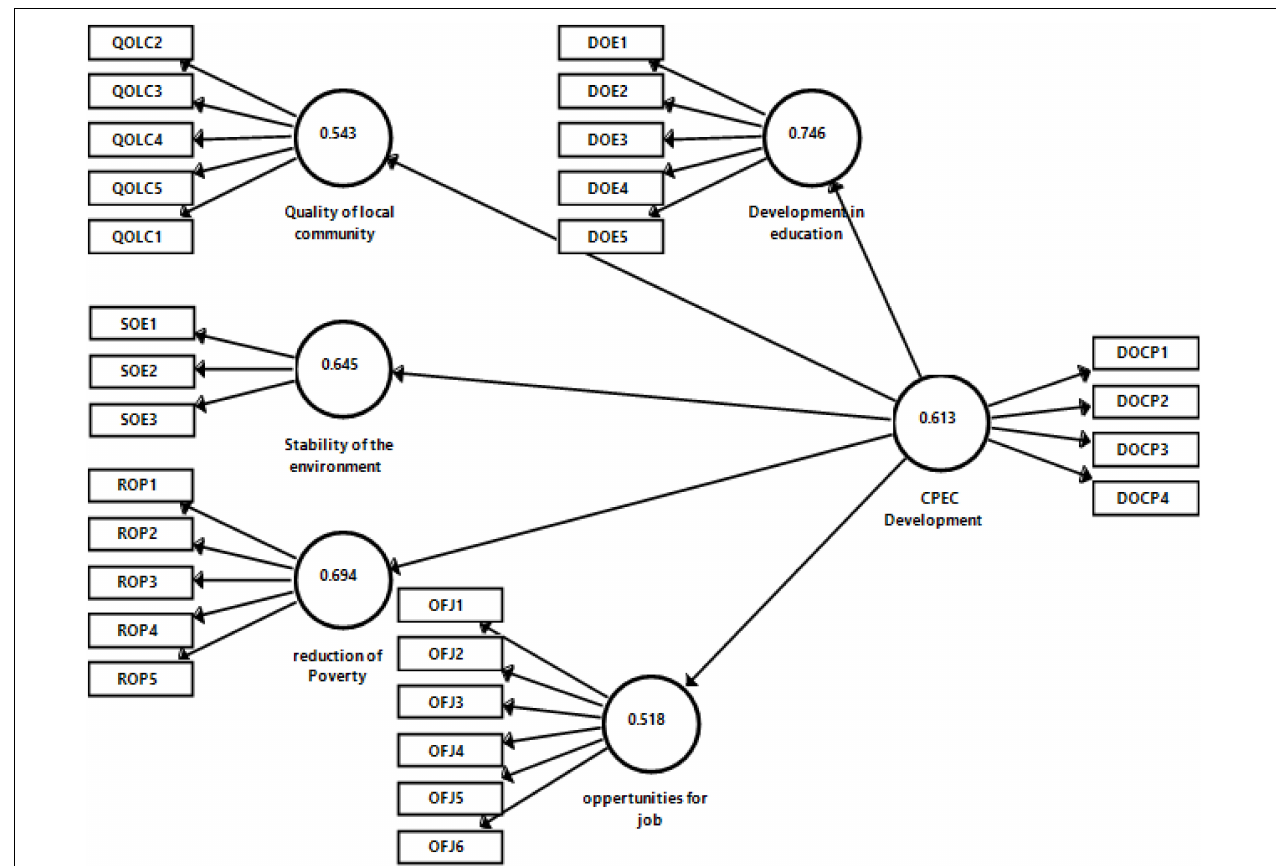
FIGURE 5 | Assessment of inner structural